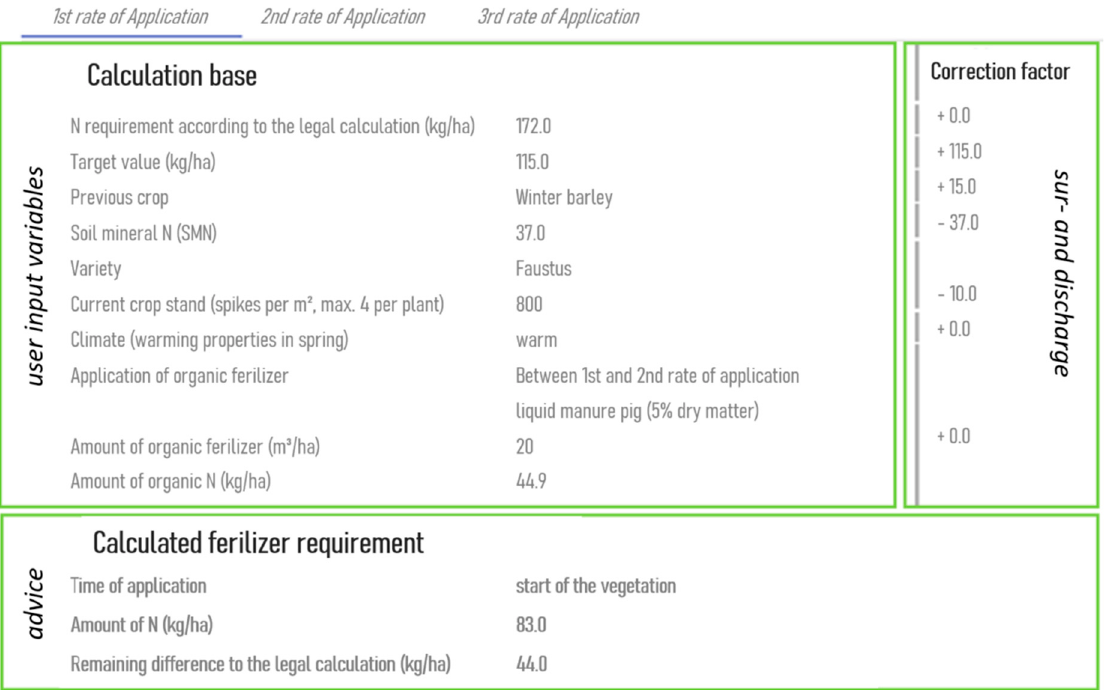
Figure 3. Input variables ( left ) including comprehensible output variables of expert knowledge ( right ) and presentation of the determined fertilizer requirement for the 1st N application rate ( below